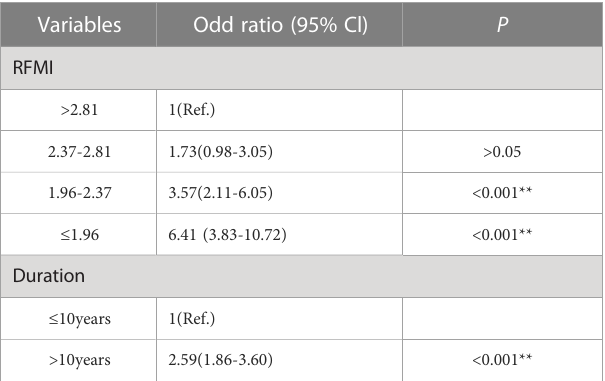
Diagonal segments are produced by ties. FIGURE 1 Receiver-operating characteristic (ROC) analysis of the duration of diabetes combined RFMI to predict DPN in T2DM patients (AUC = 0.75; 95% CI: 0.72 – 0.79; sensitivity,68.4%; speci fi city, 66.8%, P<